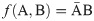
The effect of data integration on visibility.Data integration can reduce the visibility problem by making some invisible (dashed-line) edges in the SPSD visible (solid-line). The edges newly revealed by using data integration are highlighted by the thick edges. The SPSD of the Boolean function f(A,B)=A¯B is shown for integrating different types of data. A: Only transcription data (rule R1). B: Transcription data+PPI (rules R1 and R3). C: Transcription data+cis(+PPI) (rules R2 and R3).